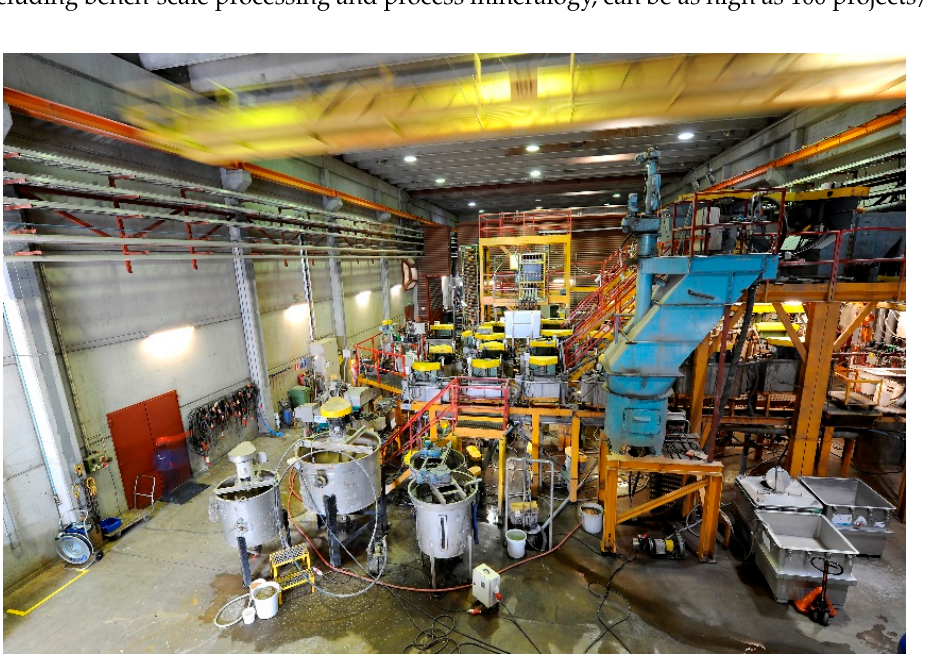
Figure 2. Pilot plant facilities at GTK Mintec.